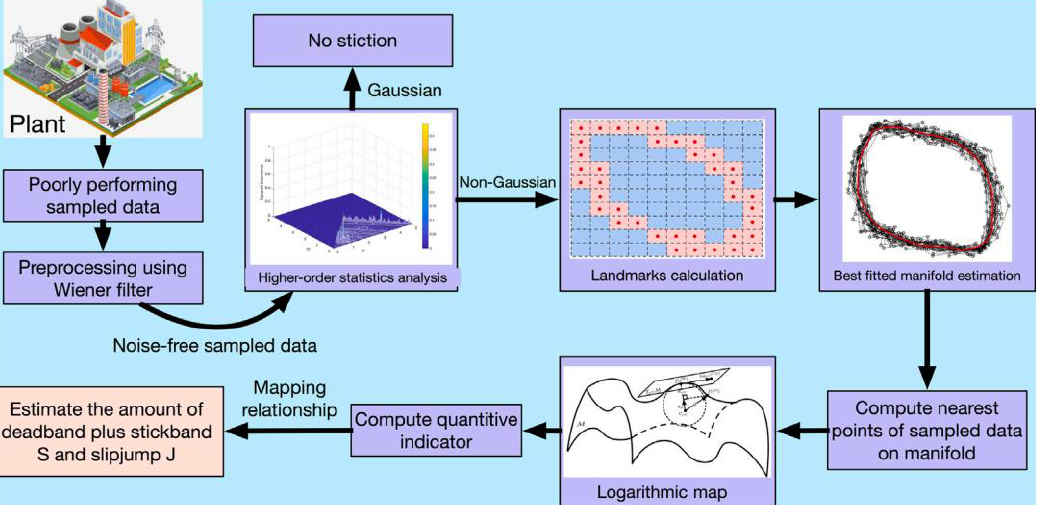
Figure 6. Diagram of the Proposed Riemannian-based Fault Detection Method for Power Plant Systems [78].